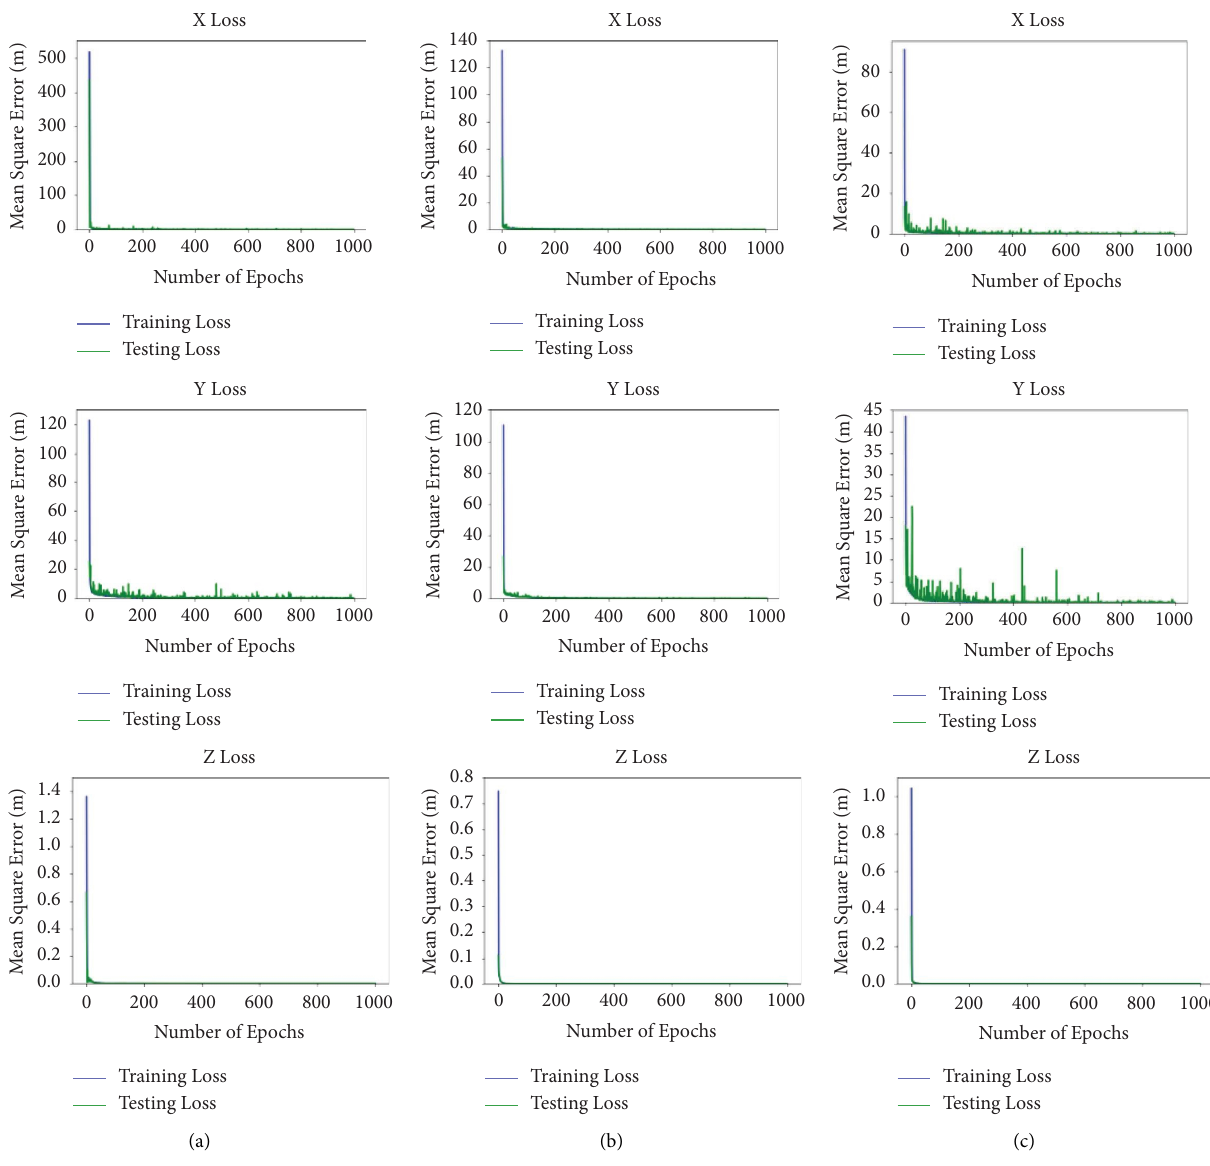
Figure 8: FCDNN loss (a) 1 AP pair, (b) 2–10 AP pairs, and (c) 1–10 AP